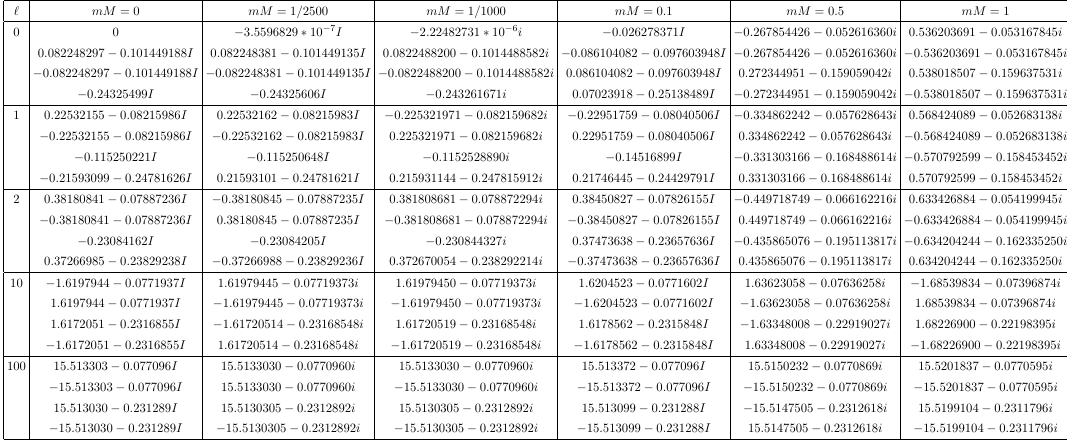
Table 2 . The QNFs ωM for massive uncharged scalar fields in the background of RN dS black holes with Λ M 2 = 0 . 04 , Q/M = 1 / 10 , and different values of ‘ .